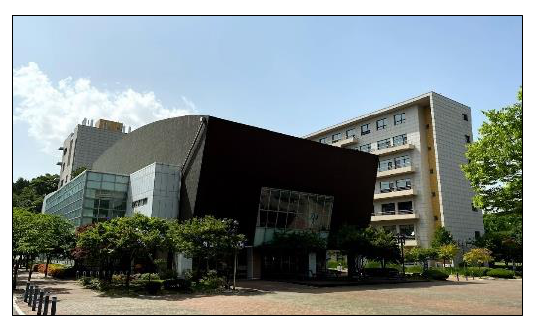
Figure 4 . The building study area for the implementation